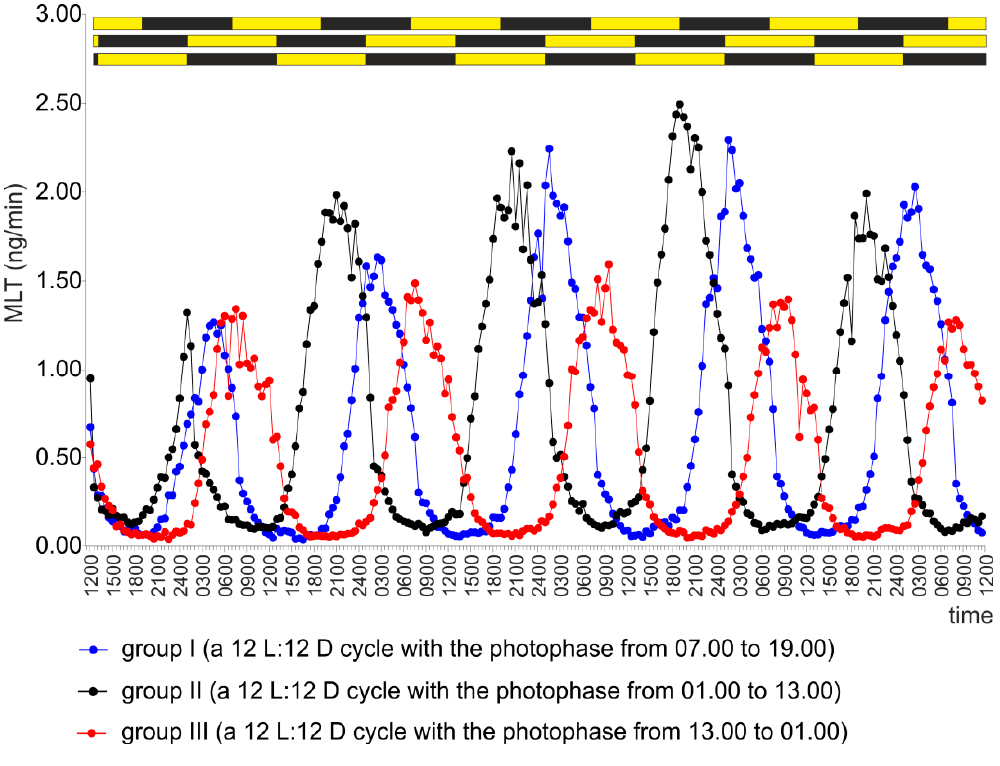
Figure 1. Experiment I. Secretion of MLT (mean) from turkey pineal organs incubated under a 12 L:12 D cycle with the photophase from 07.00 to 19.00 (group I), a 12 L:12 D cycle with the photophase from 01.00 to 13.00 (group II), or a 12 L:12 D cycle with the photophase from 13.00 to 01.00 (group III) during five consecutive days. Table 1. Parameters (mean ± SEM) characterizing the rhythm of MLT secretion from the pineal organs in experiment I. The minimum and maximum points are characterized by the time clock presented in the format “hh.mm” (the standard error in minutes) and the level of secretion in ng / min. Points I 50 and I 75 and M are expressed in units of the time clock in the format “hh.mm” (the standard error in minutes). The values labeled with di ff erent letters di ff er significantly (between groups) by the Duncan test ( p ≤ 0.05). n.d.—not